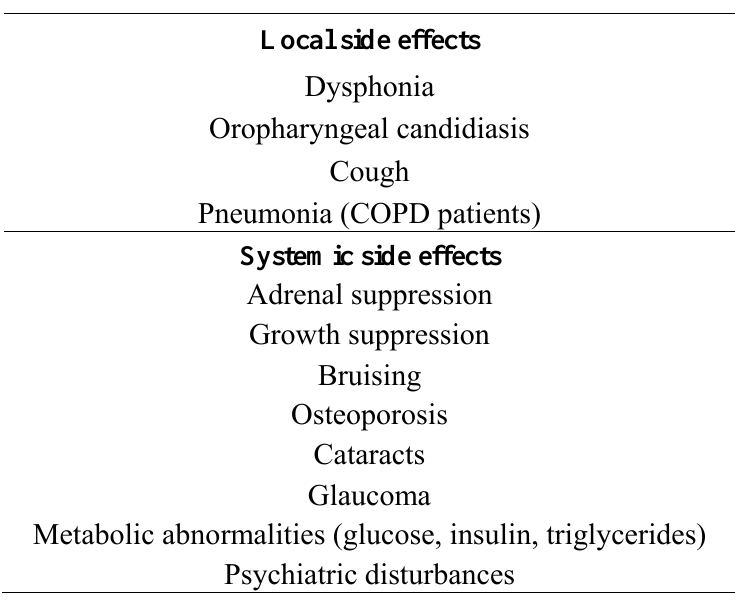
Table 2. Side effects of inhaled